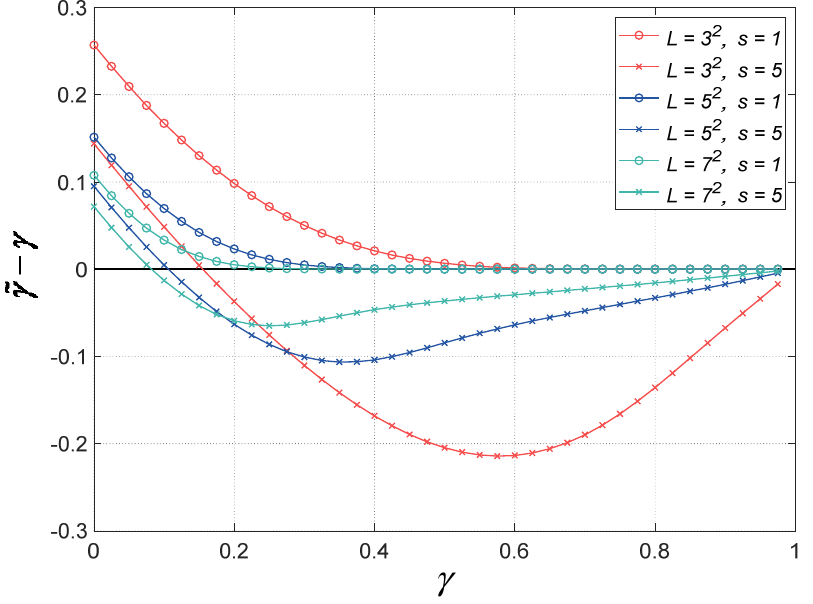
Figure 2. The difference between the estimated coherence magnitude (cid:101) γ and true coherence magnitude γ for different numbers of looks L and parameters s , using numerical